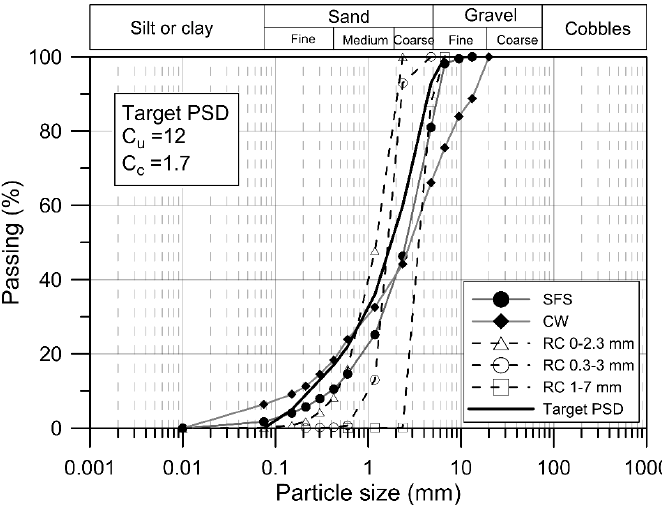
Figure 1. Particle size distribution curves of SFS, CW, RC and the target PSD of the waste matrix (modified after Qi et al. [22]).